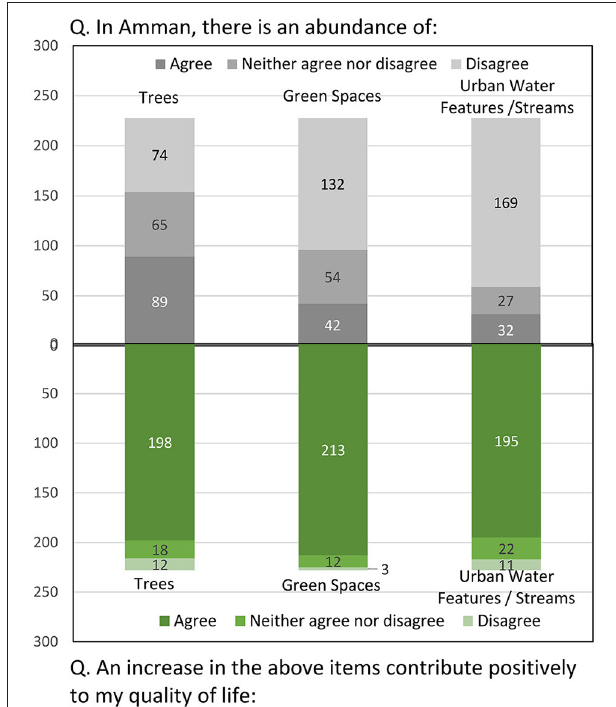
FIGURE 12 | A comparison of the respondents’ current attitudes versus their preferences for green and blue infrastructure (trees, green spaces, and water features) in